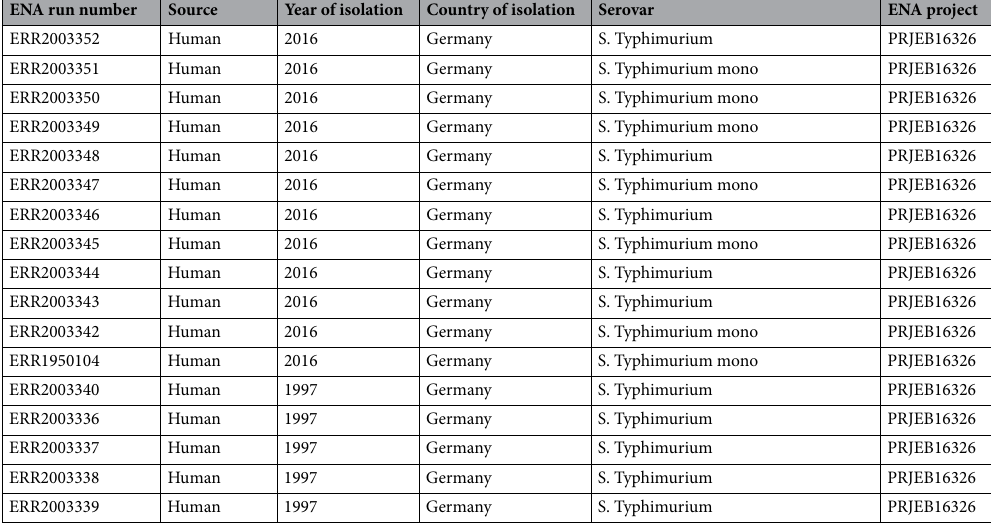
Table 2. Overview of NRC dataset for the study Banerji et al.: ‘Genome-based Salmonella serotyping as the new Gold Standard’. The dataset consists of 520 whole genome sequences, which have been submitted to